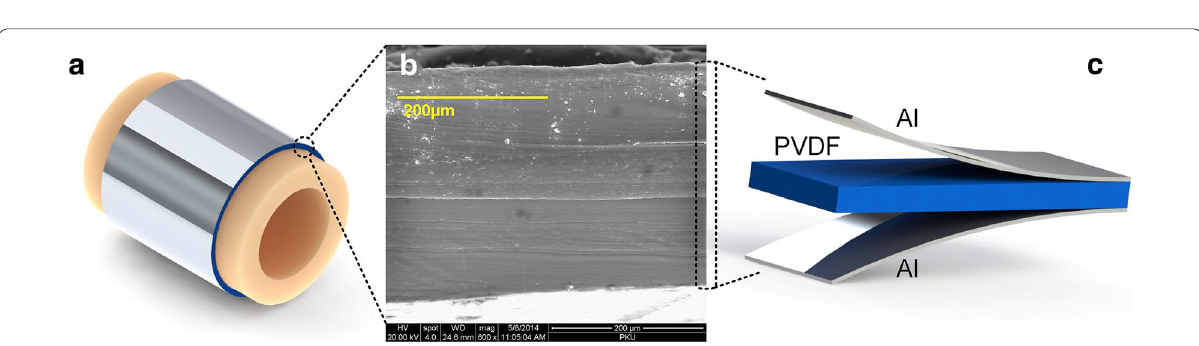
Fig. 7 a A schematic diagram of a piezoelectric generator (PG) surrounding the aorta. b cross‑sectional SEM image of PG. c PG structure